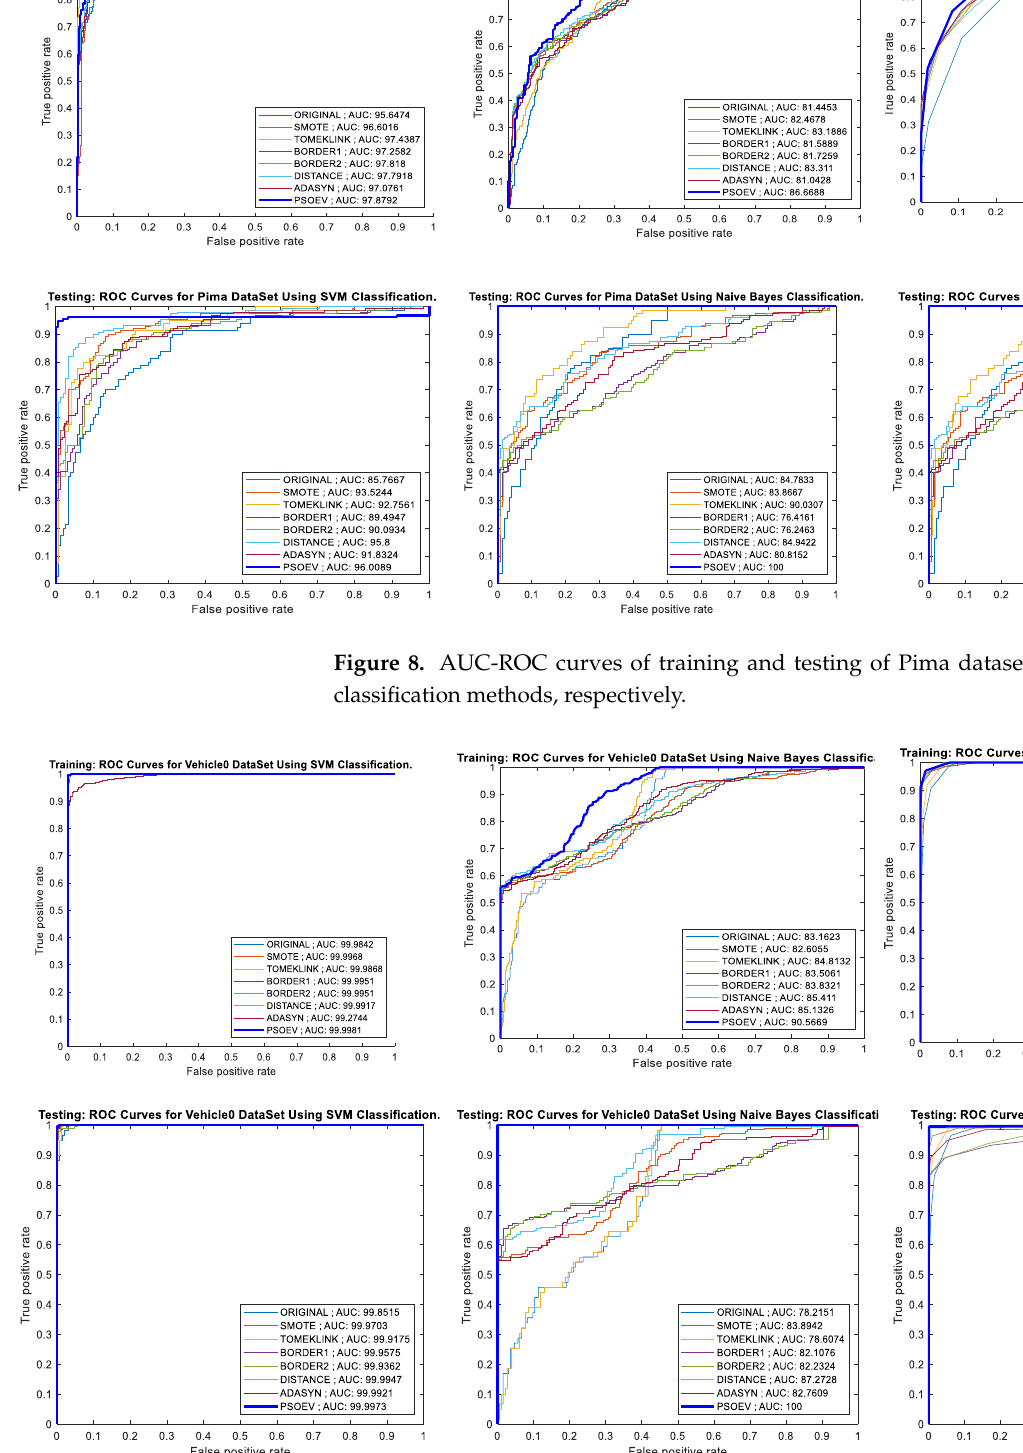
Figure 9. AUC-ROC curves of training and testing of Vehicle0 dataset using SVM, NB, and k -NN classification methods, respectively.